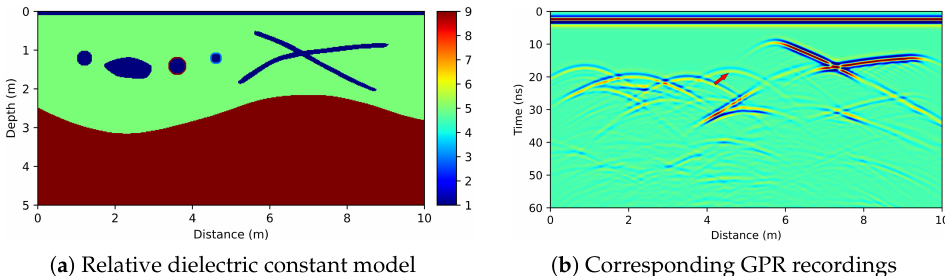
Figure 8. Synthesis model and corresponding GPR